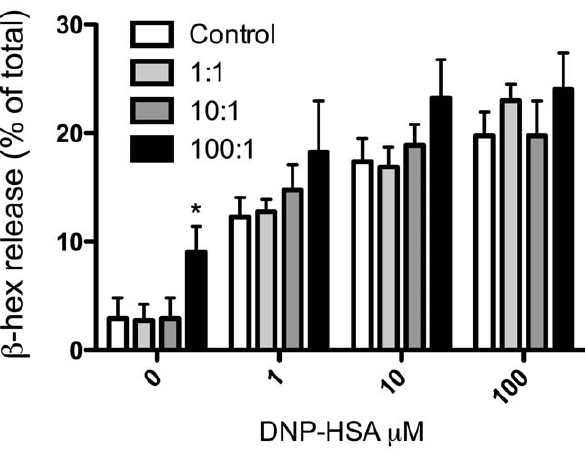
Figure 3. The effect of invitro co-culture of L.rhamnosus JB-1 with rat peritoneal mast cells isolated from untreated rats. Passively sensitized RPMC were co-cultured with bacteria at a ratio of 1:1, 10:1 and 100:1 (bacteria:mast cell) for 8 hours prior to activation. b - hexosaminidase is expressed as percentage of total b -hexosaminidase in the cells. Data is presented as mean 6 SD, n=5 independent